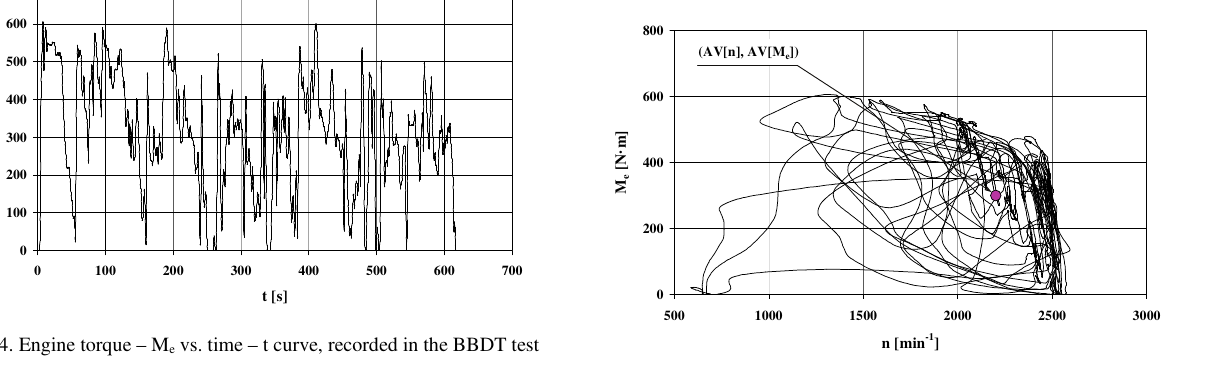
Fig. 8. The set of engine operational states: engine speed – n, torque – M e in the BBDT test; (AV[n], AV[M e ]) – the coordinates of the average values of the engine speed and engine